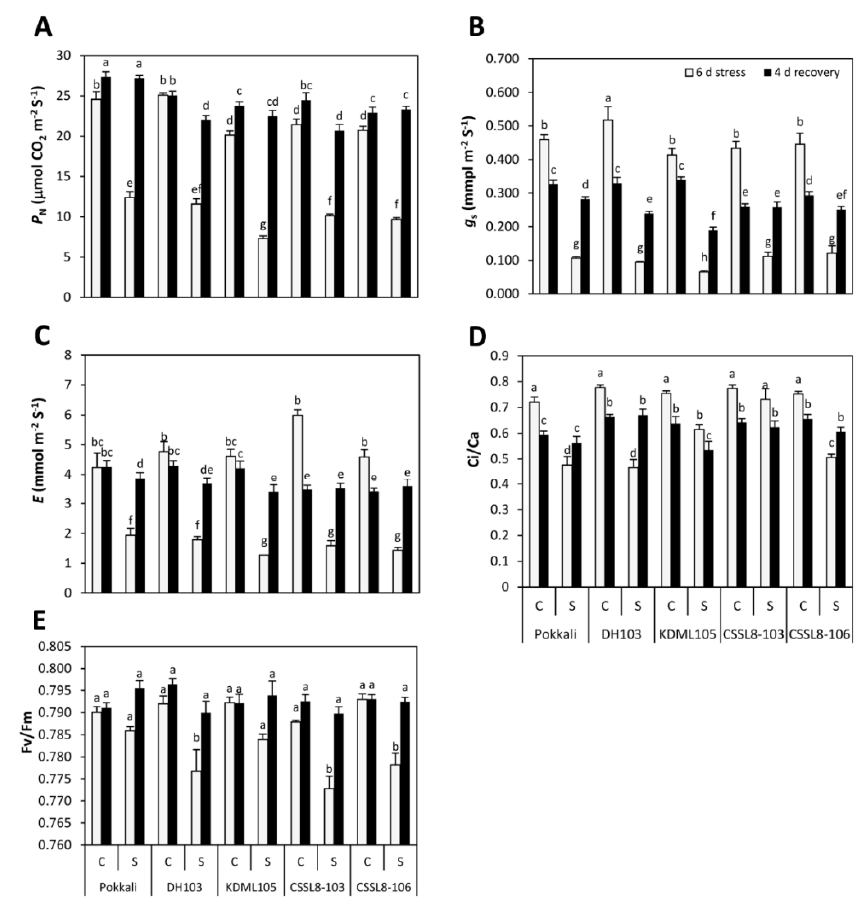
Figure 3. Photosynthetic parameters ( A ) P N , ( B ) g s , ( C ) E , ( D ) Ci / Ca and ( E ) Fv / Fm of rice plants under control and salt stress for 6 days (light gray bars) and after recovery for 4 days (black bars). C, control; S, salt stress. For description of genotypes, see Figure 1. Values are means of four replications ± SE. Different letters indicate a significant difference in the means of each group ( p ≤ 0.05).